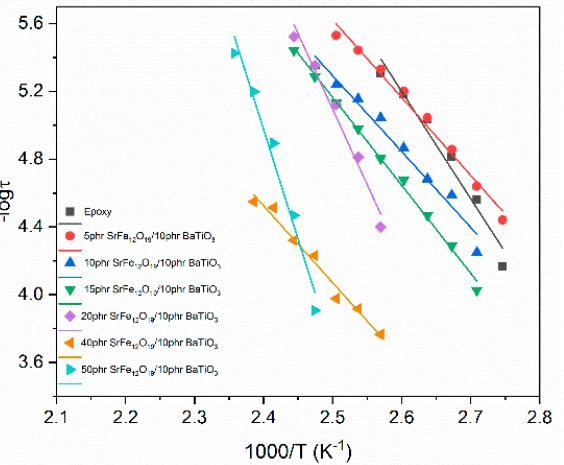
Figure 10. Relaxation time as a function of reciprocal temperature for β -relaxation process.